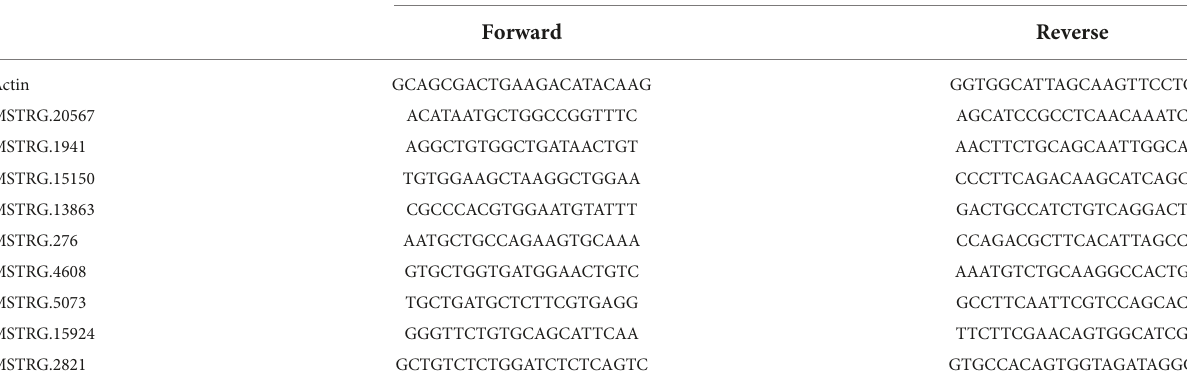
TABLE 1 Expression primers for